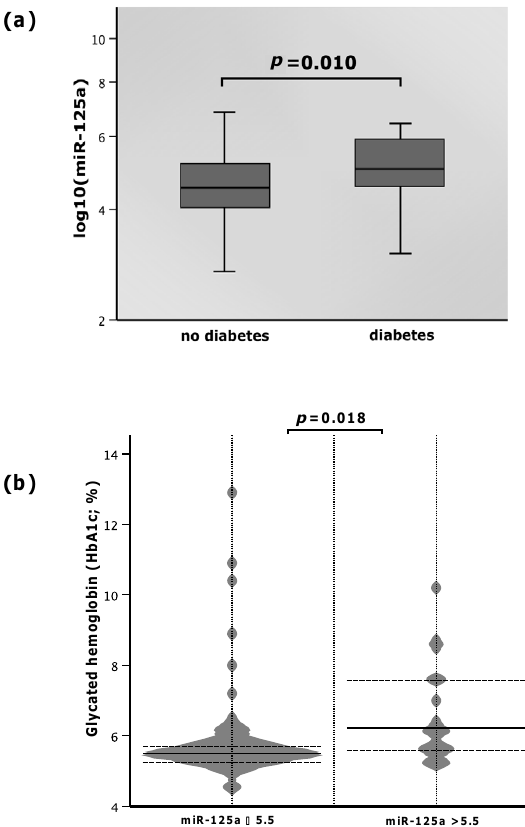
Figure 2. ( a ) MicroRNA (miR)-125a with regard to diabetes mellitus; ( b ) glycated hemoglobin